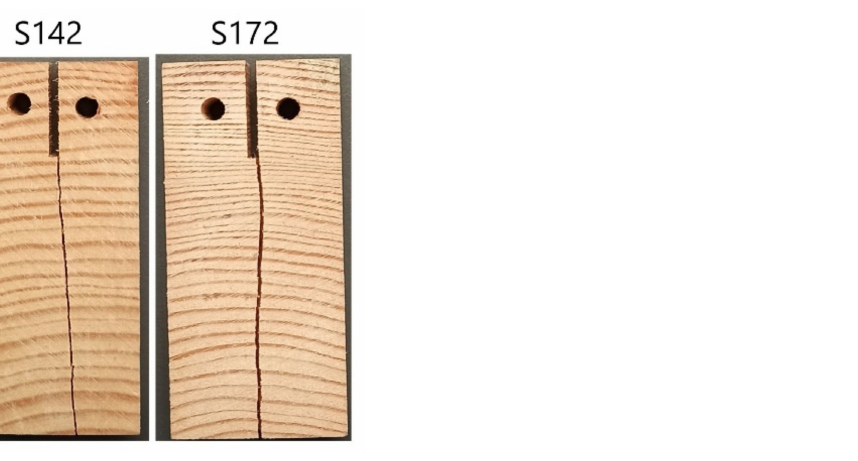
Figure 18. Shape of the fractures in samples S142 (Group 1) and S172 (Group